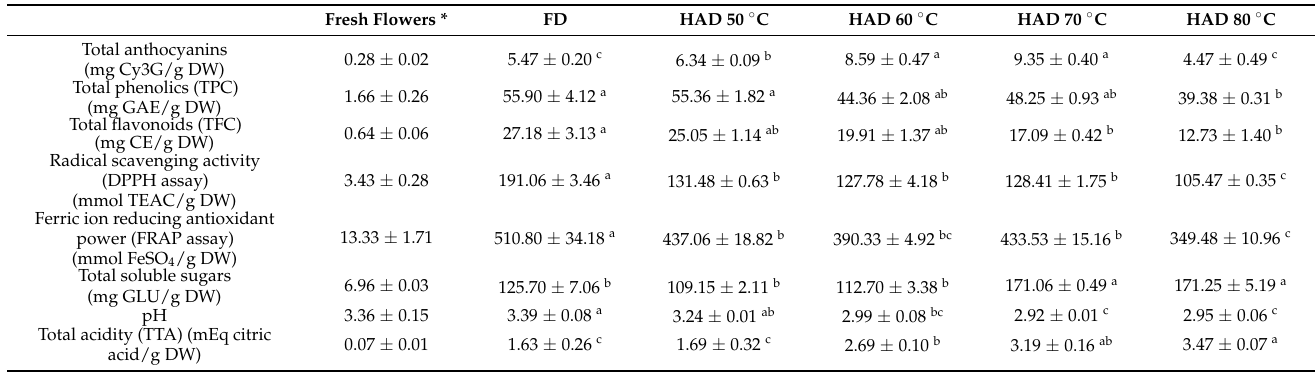
Table 3. Determination of anthocyanins, total phenolics, total flavonoids, antioxidant activity (DPPH and FRAP assay), total soluble sugars (TSS) and pH and total acidity (TTA) in B. cucullata flowers subjected to different postharvest treatments. Data are expressed as mean ± standard deviation ( n = 3). Within drying treatments, different letters mean significant differences using Tukey HSD or the Mann–Whitney U tests, with a cut-off significance of p <